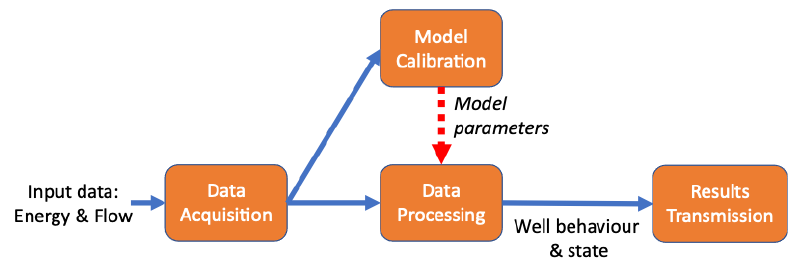
Figure 1. Data flow Monitoring